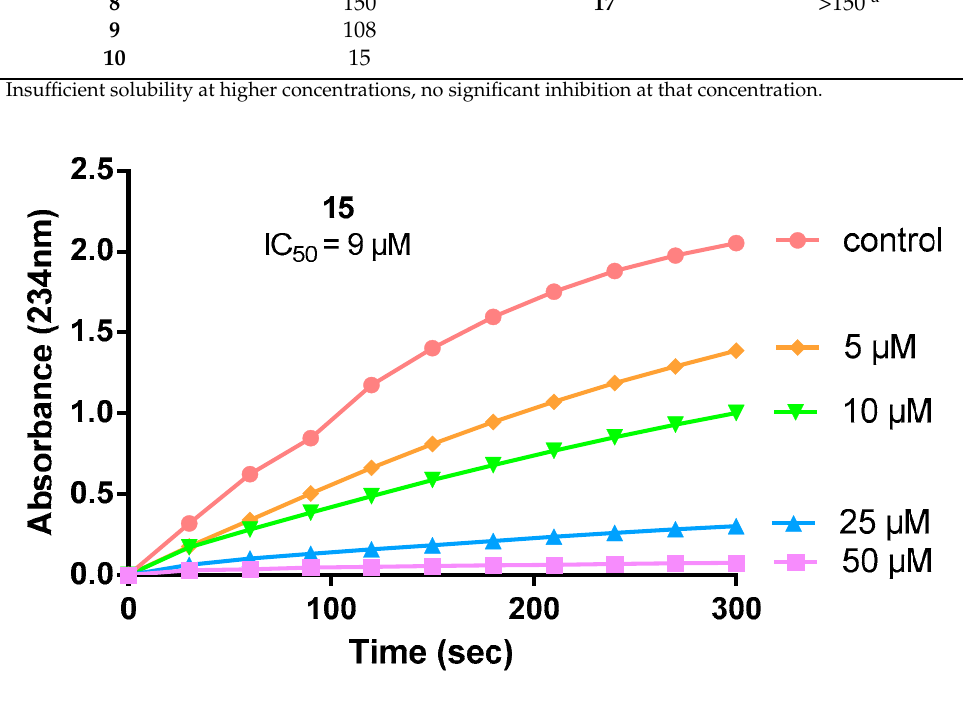
Table 1. Effect of the derivatives on LOX-3, expressed as IC 50 ( μ M), after 5 min of incubation. Compound